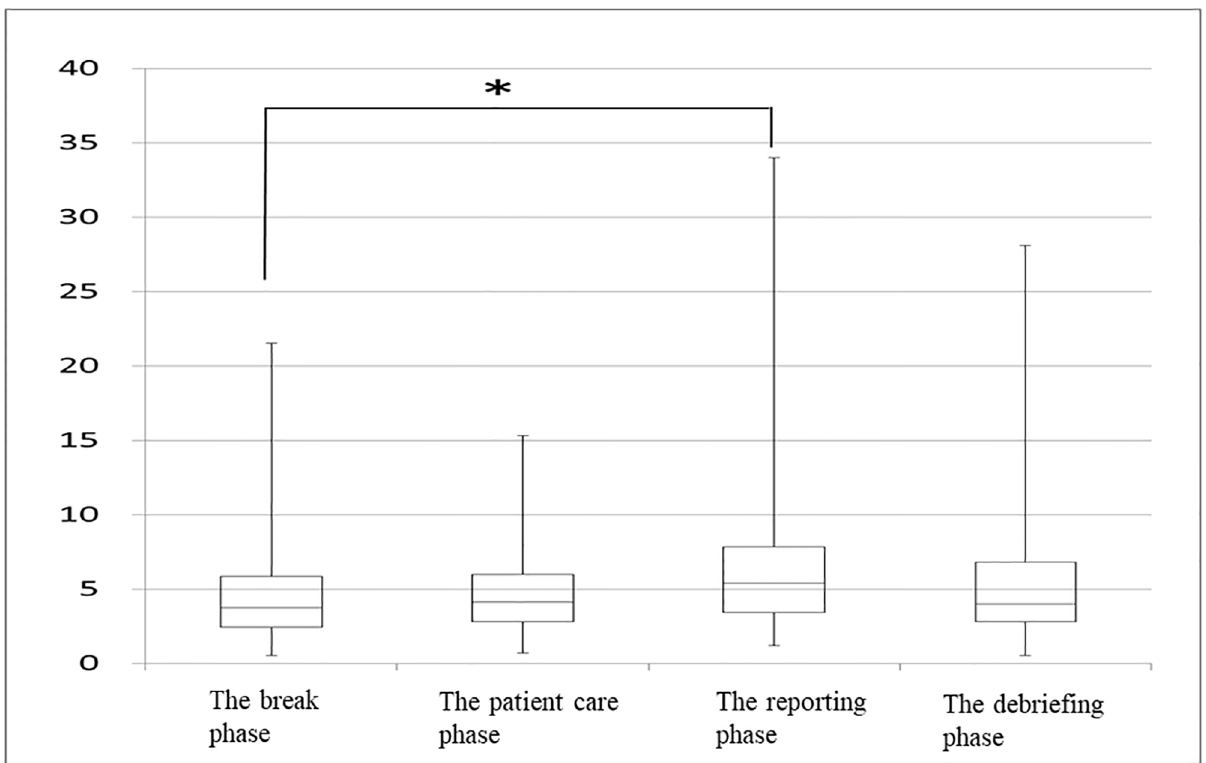
Fig 3. Changes in low frequency/high frequency component at each phase (n = 74) (cid:3) p < 0.05.